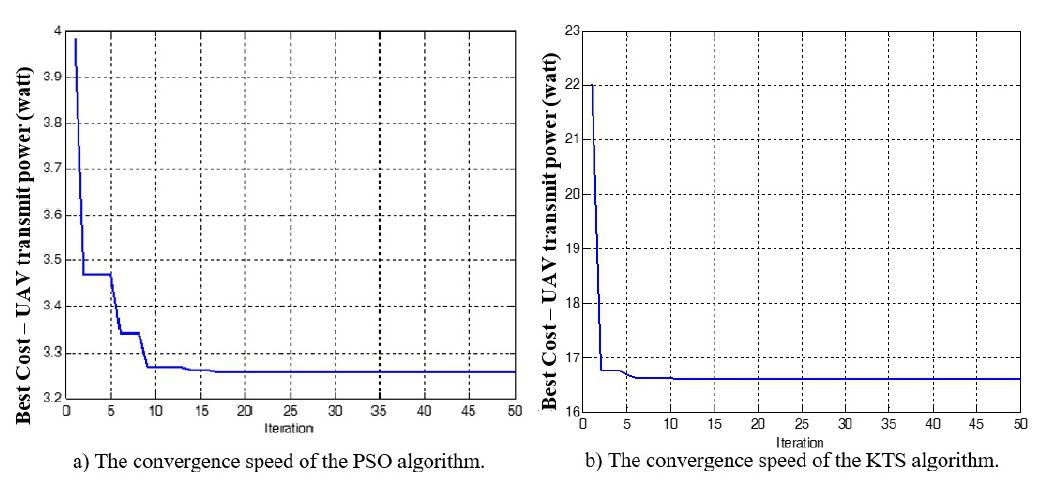
Figure 3. ( a ) The convergence speed of the PSO algorithm; ( b ) the convergence speed of the KTS algorithm, for the case of 960 indoor receivers inside each